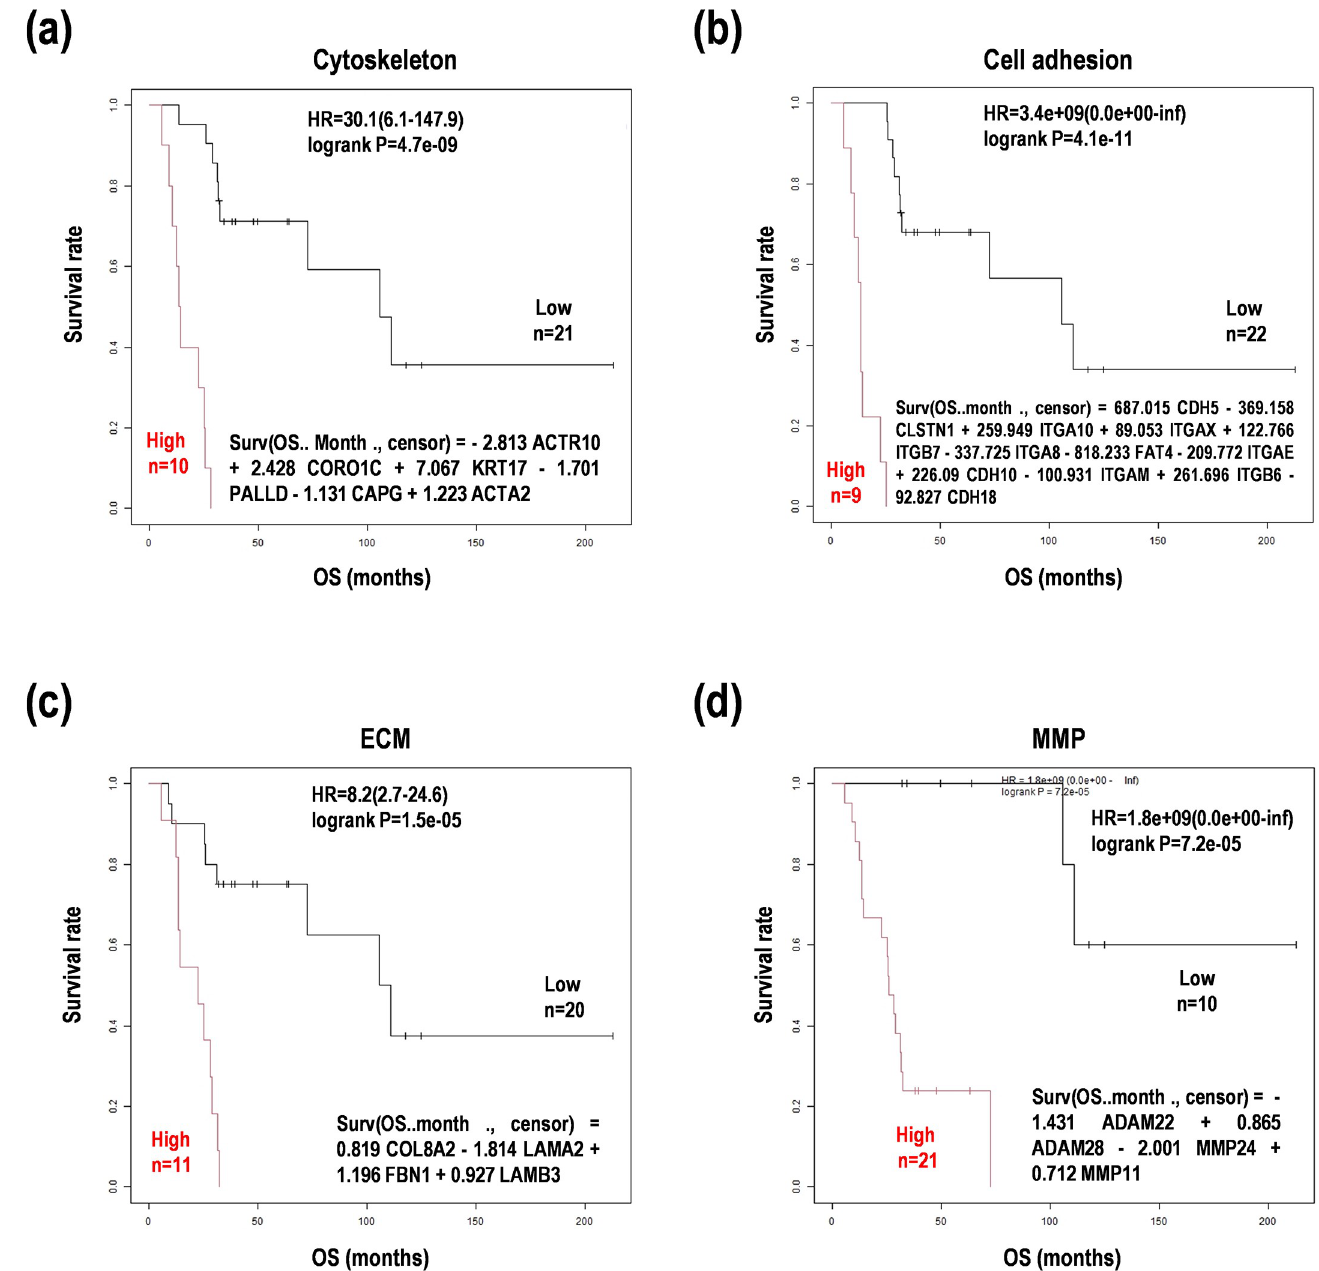
Fig 2. Survival analyses with defined prognosis prediction formulas. Survival distribution of the PCNSL subgroups were divided by the formulas from the study. OS; overall survival, HR; hazard ratio. HRs with 95% confidence interval (CI) were shown with p-values in the log-rank test. ( a ) Cytoskeleton. ( b ) Cell adhesion. ( c ) Extracellular matrix (ECM). ( d ) Matrix metalloprotease (MMP). HR; hazard ratio, OS; overall